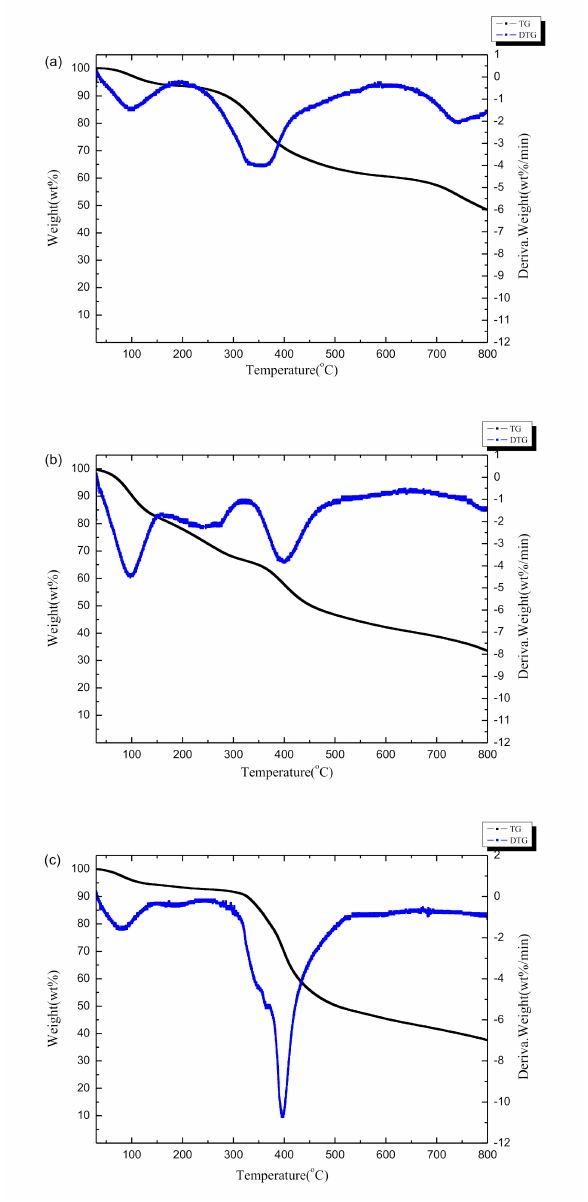
Figure 3. Thermogravimetry (TG) and derivative thermogravimetry (DTG) curves of ( a ) Al-lignin, ( b ) Ph-lignin and ( c )